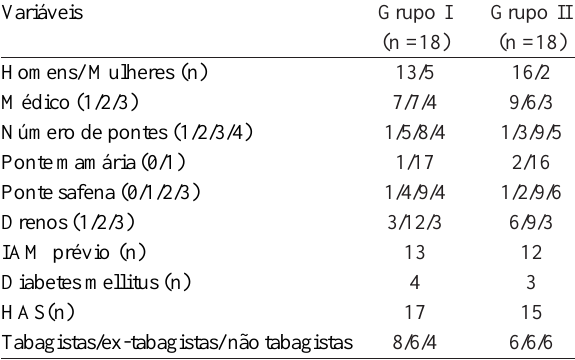
Fig.1 – Comparação da DCVF e DVEF